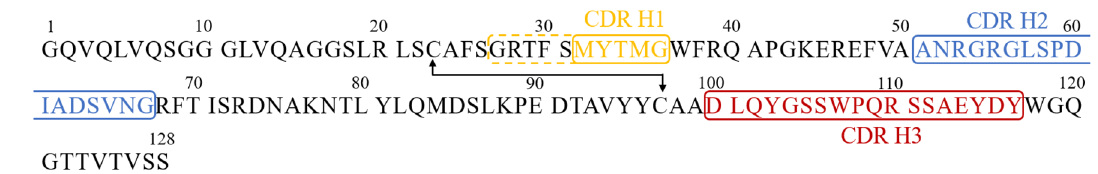
Figure 4. Amino acid sequence of BCD090-M2. The numbering is the same as in the PDB files 6EZW and 6F0D. The CDR regions according to Kabat definition are indicated with color and frames. In the case of CDR H1, the AbM definition (dashed frame, residues 27-36) was